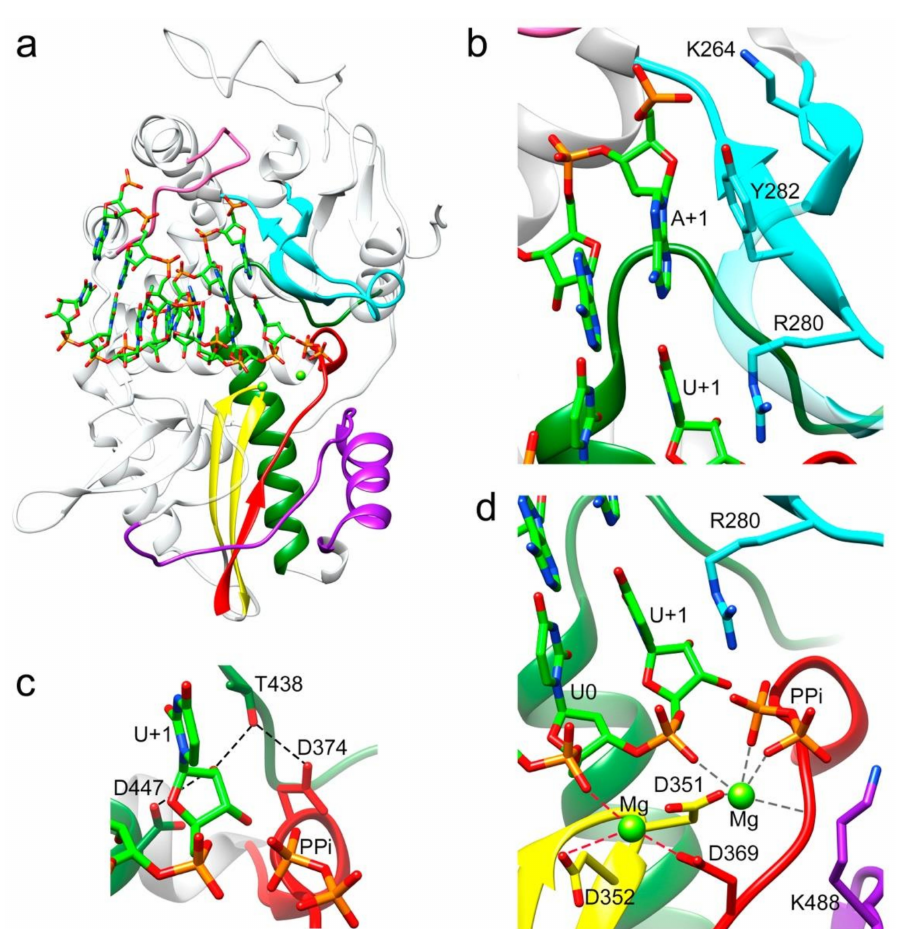
Figure 2. Interactions between the TaV RdRP and the template/primer/product RNA in the RdRP cat- alytic cavity. ( a ) Side view of the overall structure of the ∆ 10-TaV pol ∆ 607-624/5 (cid:48) CAAAAUUU3 (cid:48) /UTP complex with the UMP molecule incorporated in a pretranslocation state. The polymerase molecule is shown as grey ribbons, with the conserved structural motifs highlighted in different colors: G (pink) F (cyan), A (red), B (green), C (yellow) and D (purple). The dsRNA molecule bound to the central cavity is represented as sticks in the atom type color: C green, P orange, O red and N blue. Panels b to d show different close up views of the RNA–protein interactions. Molecules are colored as in A and selected protein side chains are represented as sticks and explicitly labeled. ( b ) The template acceptor base A+1 appears to always be stacked to the Y282 side chain, whereas its triphosphate moiety appears salt bridged to K264 in motif F. A second stacking interaction was established between the guanidinium group of R280 (motif F) and the newly incorporated U in position +1. ( c ) The hydrogen bonding network involved in the 2 (cid:48) -hydroxyl recognition of the recently incorporated U+1 nucleotide. Hydrogen bonds are shown as black dashed lines. ( d ) Organization of the metal cluster after nucleotide incorporation into RNA, the product before translocation. Coordination distances < 2.5 Å for Mg 2+ (B) are shown as dark grey dashed lines. In this structure, Mg 2+ (A) is loosely coordinated as would be expected of a complex trapped in post-catalysis (distances < 3 Å are shown as red dashed lines). The liberated pyrophosphate (PPi) is present in the catalytic site, coordinated with Mg 2+ (B) and salt bridged with residue